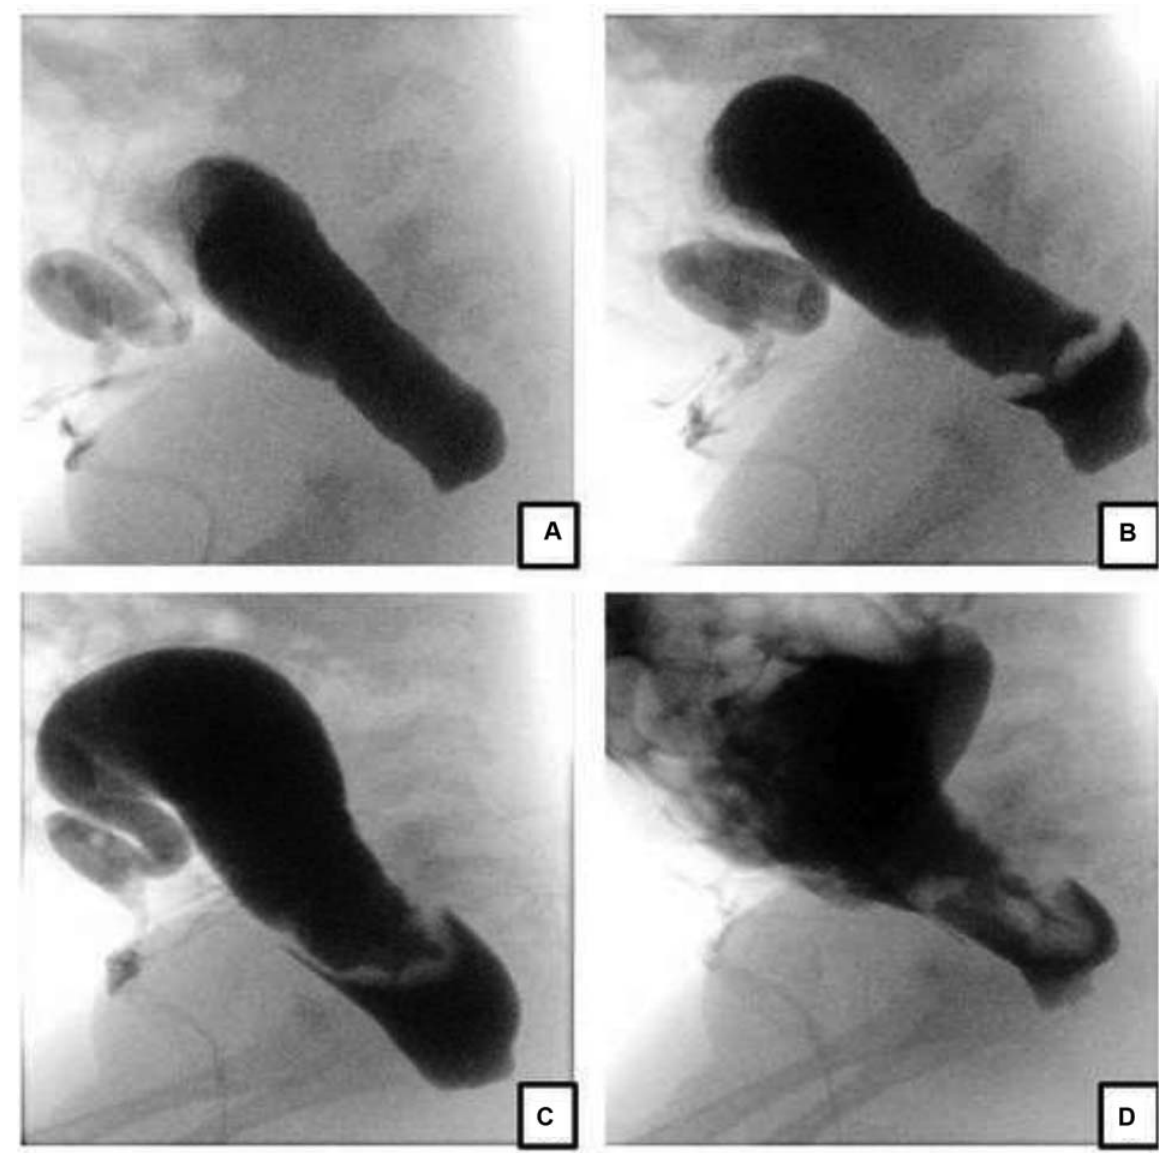
Fig. 1 High-pressure distal colostogram lateral views (case 1). ( a ) Opaci fi cation of distal colon with convexity of distal rectal pouch. No rectourinary fi stula is demonstrated. ( b ) Rectal pouch perforation with extraperitoneal contrast extravasation. ( c ) Progression of the extraperitoneal contrast extravasation. ( d ) progression of the contrast extravasation, extending into the